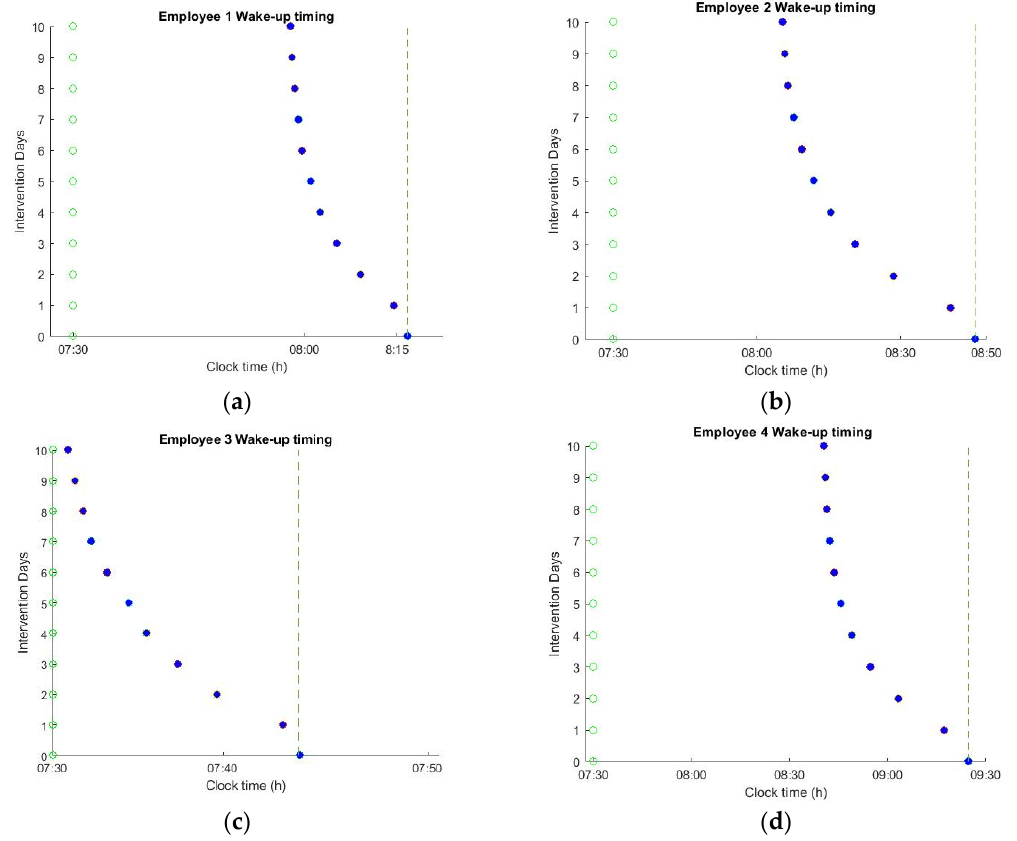
Figure 6. Predicted shift in wake-up times as a result of applying the optimal lighting schedules.